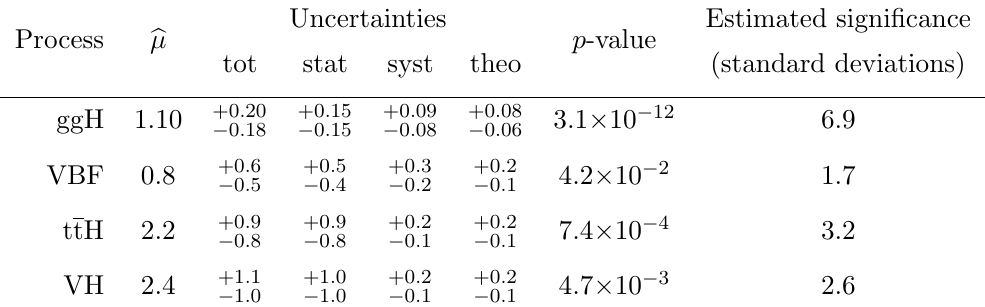
Table 4 . Results of the (cid:12)t to the signal strength modi(cid:12)er for each production mode. The total uncertainties as well as a their statistical, systematic, and theory components are shown. The last two columns report the p -value relative to the observed rates and referred to the abscence of the considered production mode, and its corresponding estimated